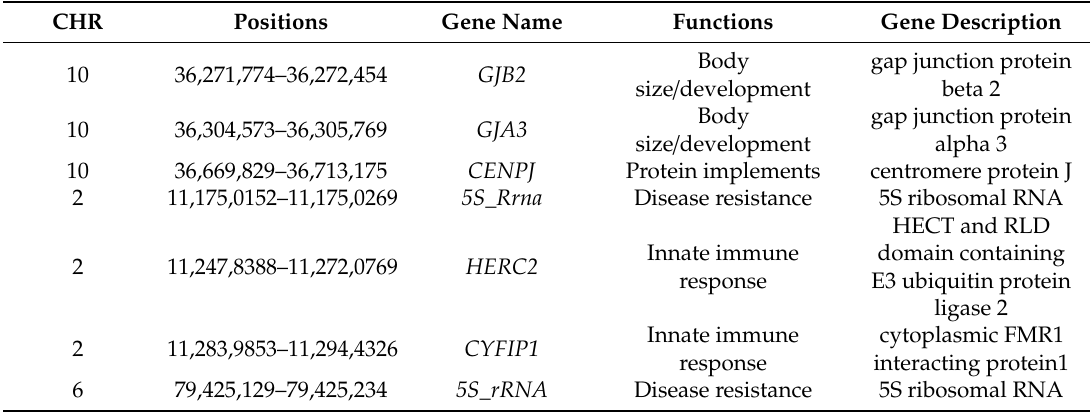
Figure 5. Manhattan plot of incidence of each SNP in the ROH across individuals. The dashed line represents the 45% threshold. Table 4. The candidate genes located in genomic regions with the highest ROH frequency associated with important traits.